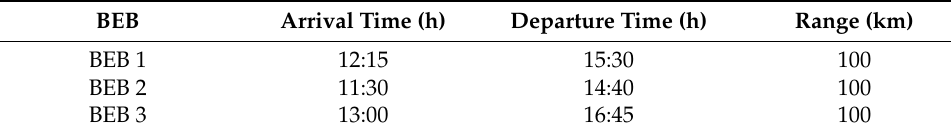
Table 3. Charging specifications of the BEBs during the day.